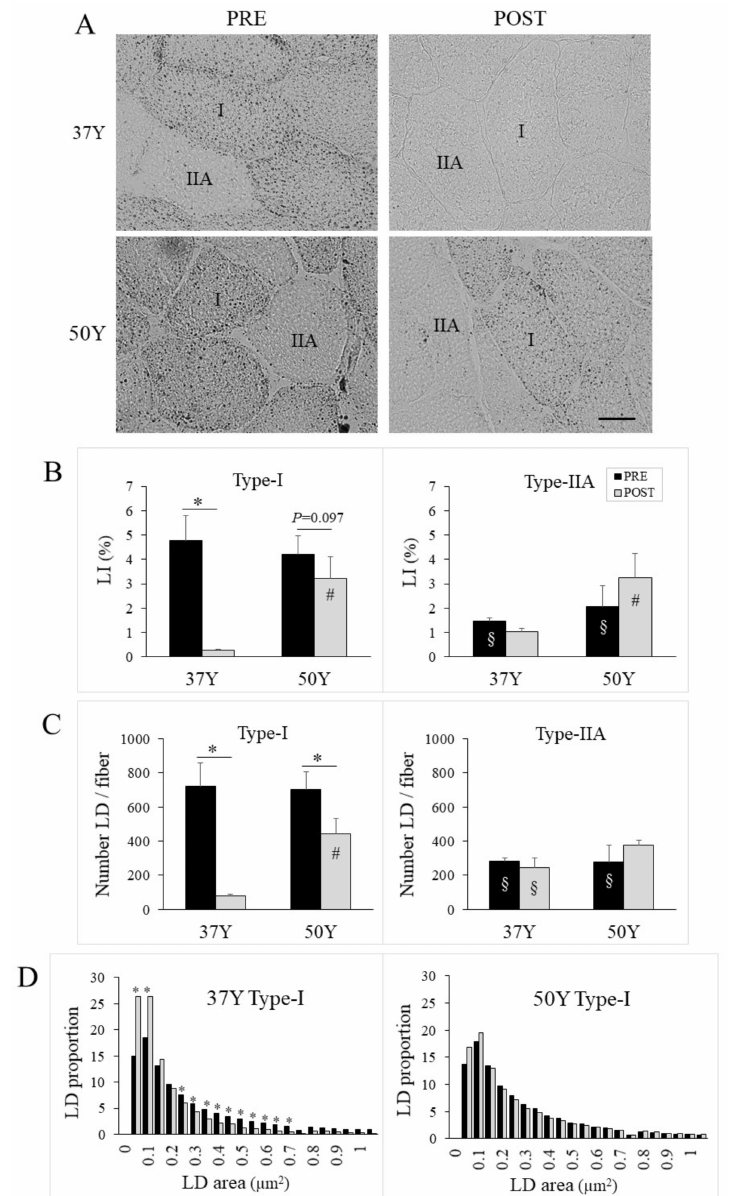
Figure 2. Intramyocellular lipid content. ( A ) Representative images of cross-sections stained with Oil red O for PRE and POST muscles of 37Y and 50Y runners; the scale bar represents 20 µ m. ( B ) Lipid content index (LI) expressed as a percentage of fiber area occupied by lipid droplets (LD); statistical interaction was p = 0.037 between time and group for type-I fiber. ( C ) Mean number of LD per fiber in type-I (left) and type-IIA fiber (right) for PRE (black bars) and POST (gray bars) muscles of middle-aged (37Y) and master (50Y) runners; statistical interaction was p = 0.045 between time and group for type-I fiber. ( D ) Frequency histogram of droplet area for type-I fibers in PRE (black bars) and POST (gray bars) muscles of 37Y (left) and 50Y (right) runners. * p < 0.05 between PRE and